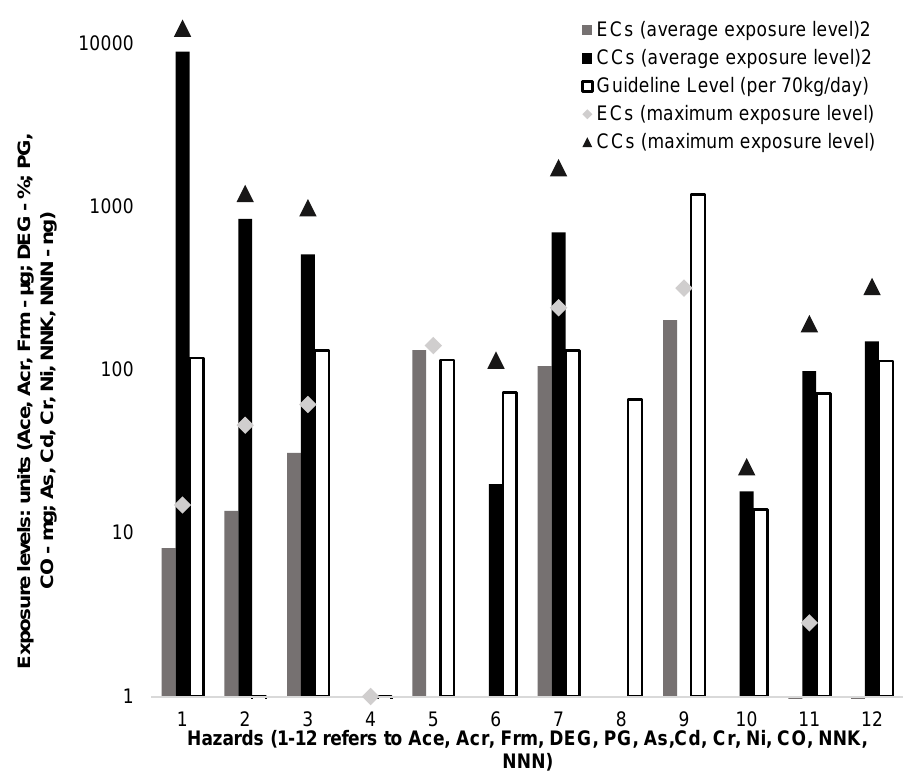
Figure 1. Risk comparison of maximum/average hazards’ exposure levels to guideline levels.